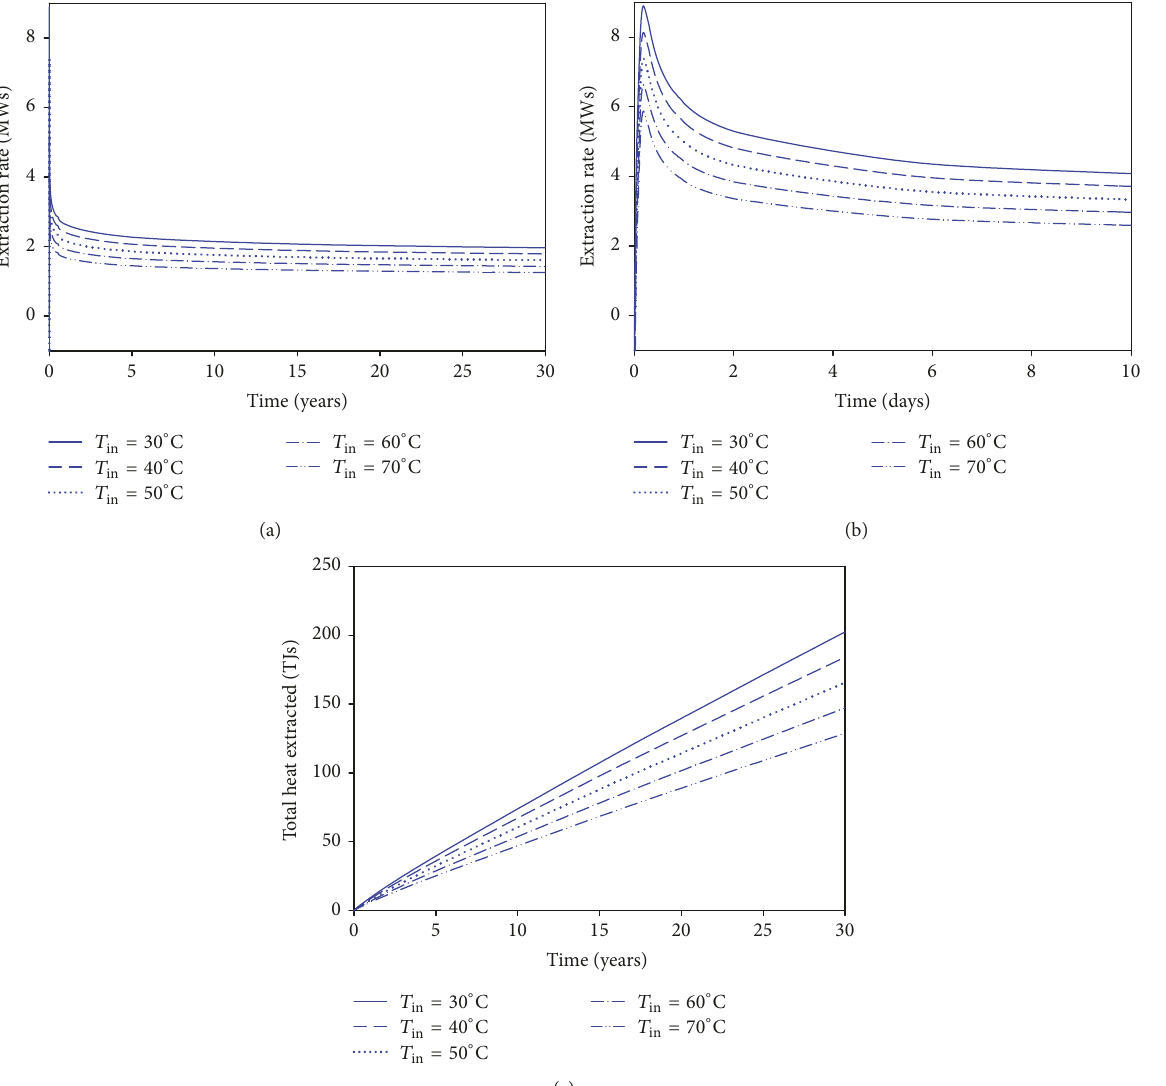
Figure 8: Thermal power and total heat extracted for different injection temperatures: thermal power (a) for large time and (b) for short time and (c) total heat